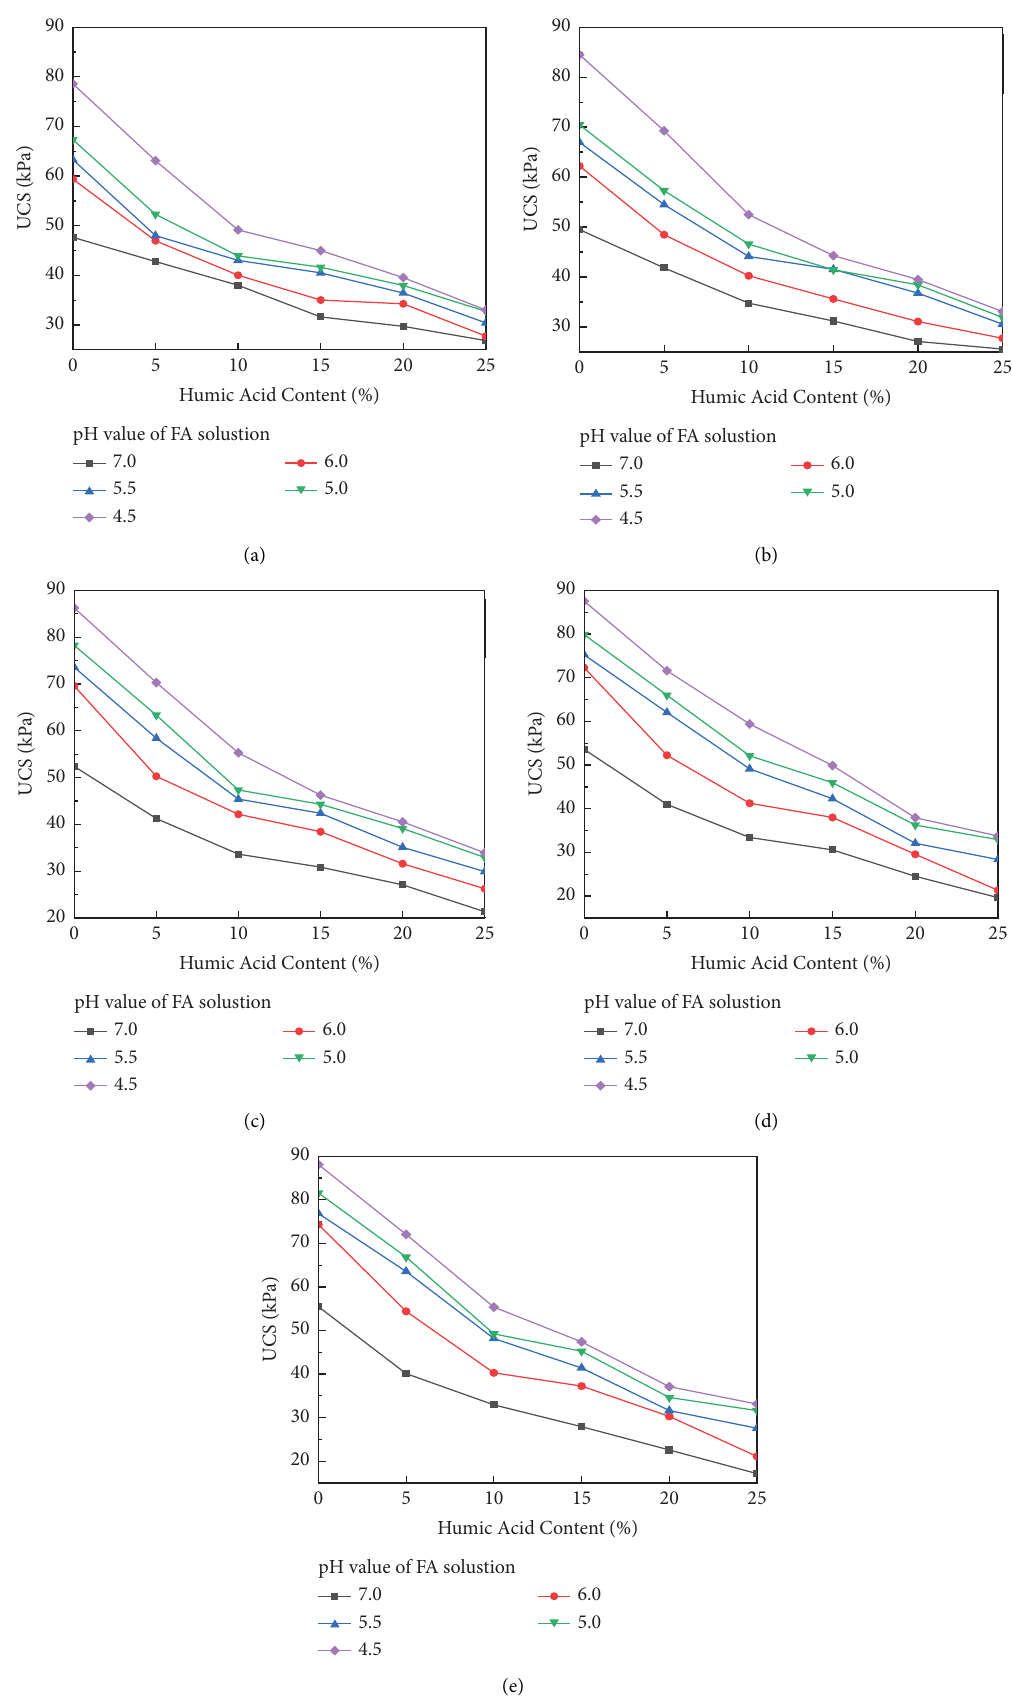
Figure 7: Relationship curve between sample UCS and the content of HA reagent. (a) 28d, (b) 90d, (c) 180d, (d) 270d, and (e)